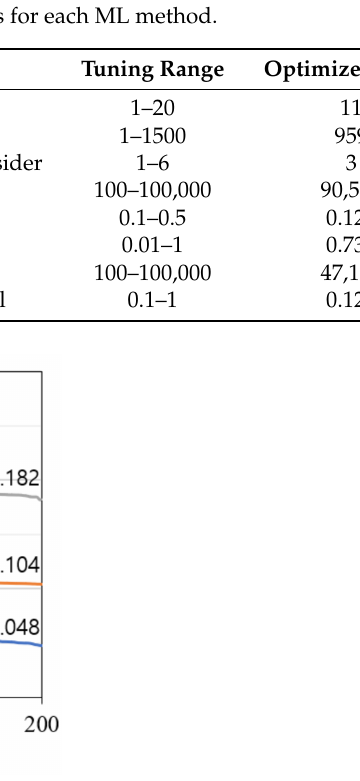
Figure 10. Cross-validated RMSE in descending order versus the number of iterations. The results show that the performance of SVR RBF is about 1.8 times higher than that of the SVR Linear . This result implies that the relationship between the AE parameters and the degree of damage is a complex and nonlinear problem. As for comparison between two different nonlinear models, the RF (RMSE = 0.048) showed 2.2 times higher optimizing performance than the SVR RBF (RMSE =